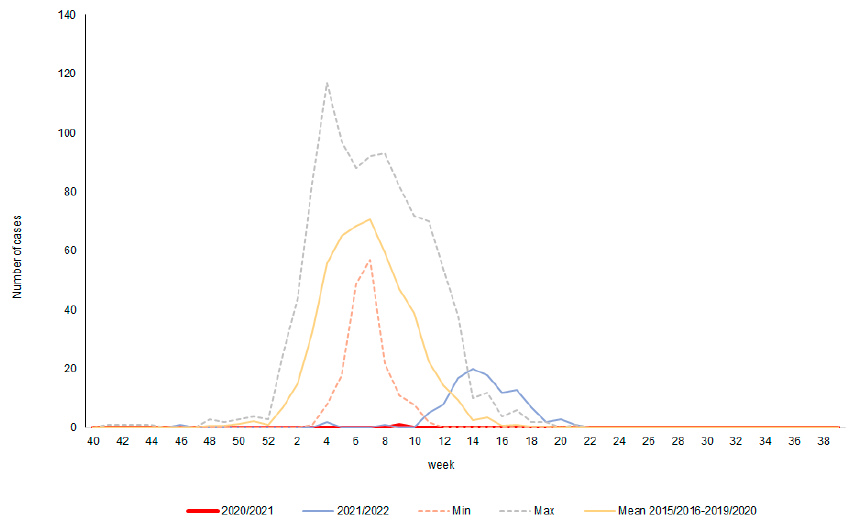
Figure 4. Comparison of averaged data from epidemic seasons before and after pandemics